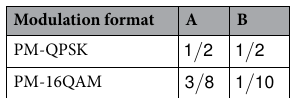
Table 7. Constant for use in Eq. (1) to estimate the BER for a AWGN